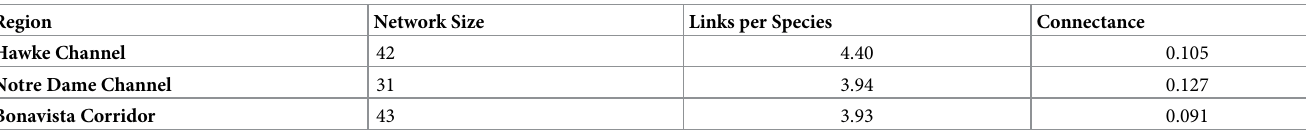
Table 4. Three food web metrics calculated for the food webs in each region.